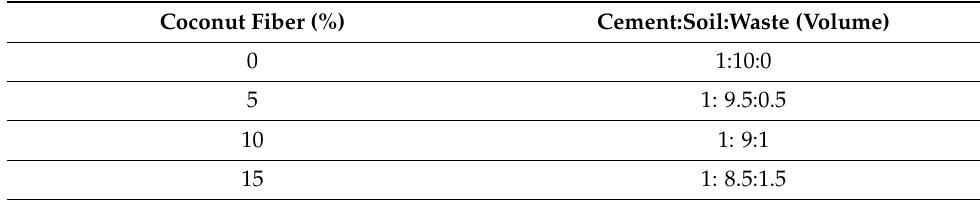
Table 1. Mixture used.